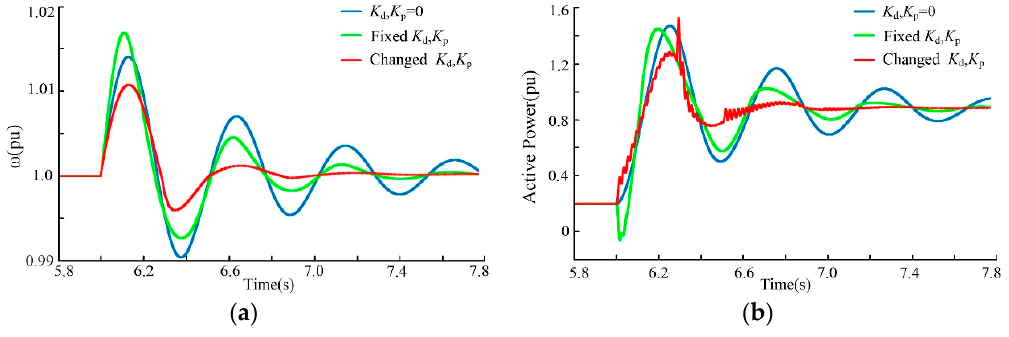
Figure 10. Coordinated action of damping control and inertia control. ( a ) Grid frequency; ( b ) electromagnetic power of the equivalent SG.